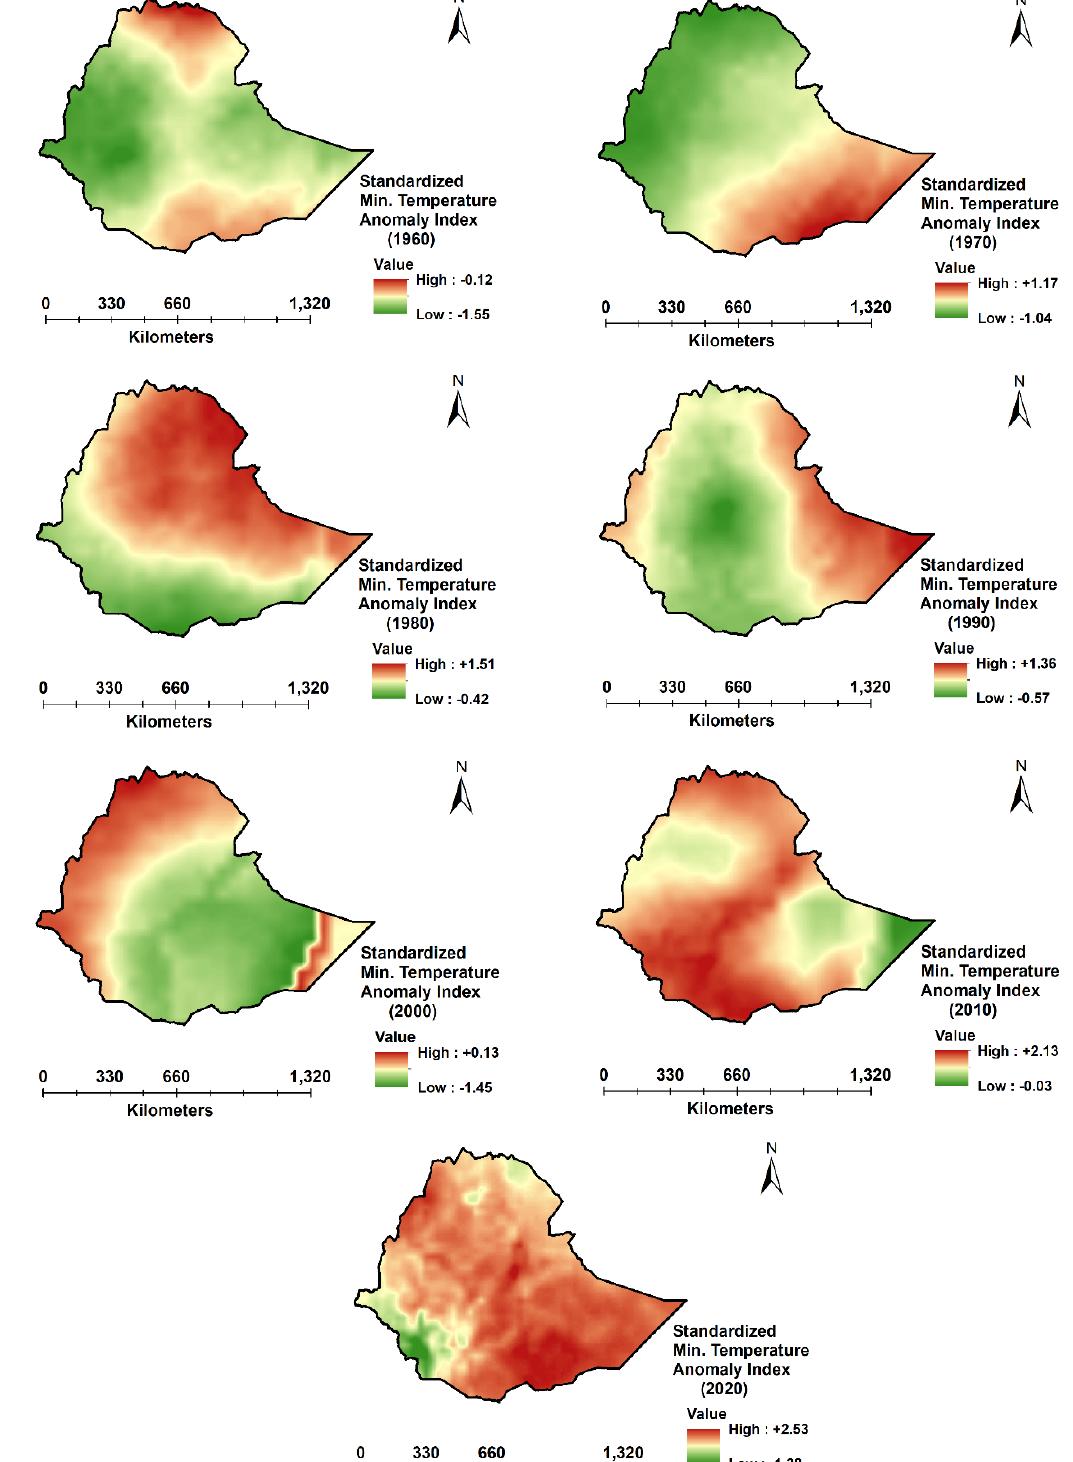
Figure 6. Standardized min. temperature anomaly index maps for 1960, 1970, 1980, 1990, 2000, 2010, and 2020 in the study of Ethiopia.